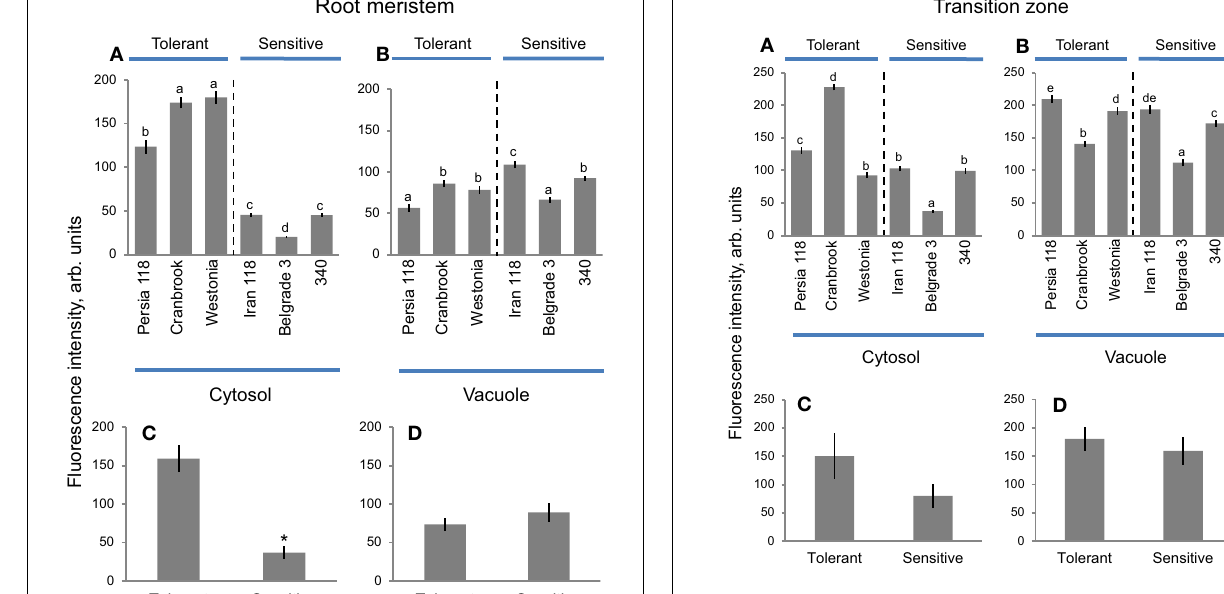
FIGURE 8 | Na + accumulation and patterning between cytosol and vacuole in transition root zone in bread wheat genotypes. Intensity of CoroNa Green fluorescence in cytosolic (A) and vacuolar (B) compartments (arb. units) in transition root zone of six bread wheat varieties contrasting in their salinity tolerance. Mean ± SE ( n = 72–96 cells from at least six individual plants). Different lowercase letters represents significant difference between varieties at P < 0 . 05. (C, D) Averaged pooled values for cytosolic (C) and vacuolar (D) Na + intensity for salt-tolerant and salt-sensitive clusters shown in A , B . Mean ± SE ( n = 215 to 300; three varieties × 72–96 cells analyzed for each